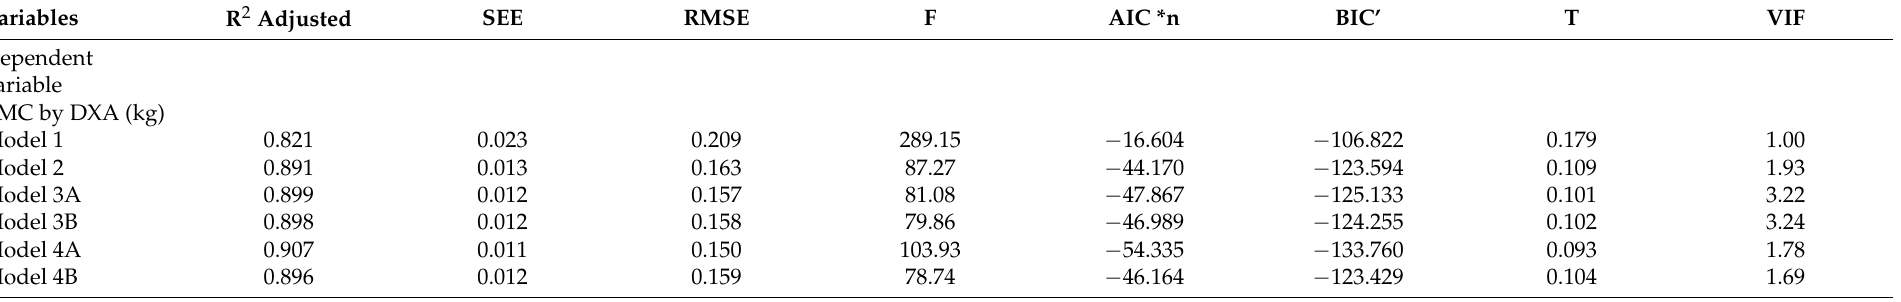
Table 4. Three sets of linear multiple regression to predicted BMC in children and adolescents diagnosed with human immunodeficiency virus